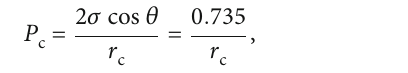
distributions of the seven 2